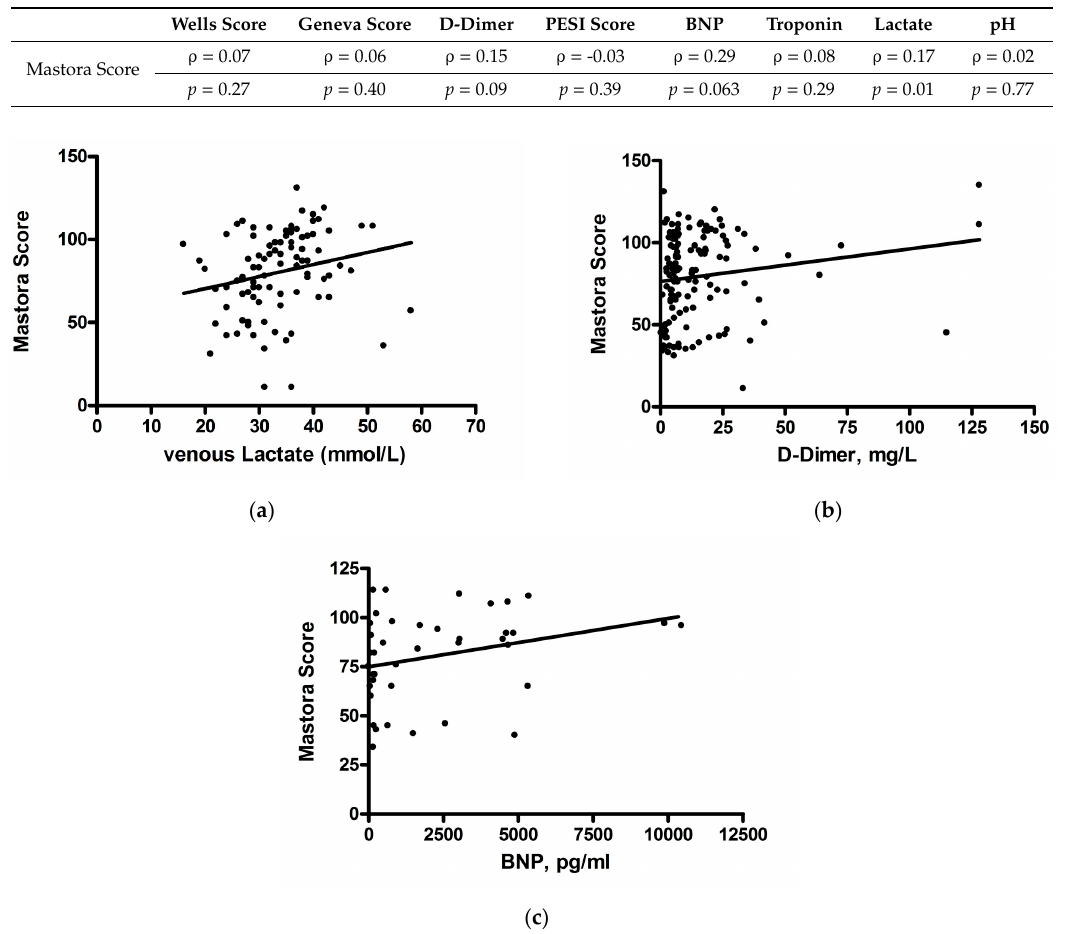
Figure 2. Associations between Mastora score and lactate level ( a ), D-dimer ( b ), and BNP ( c